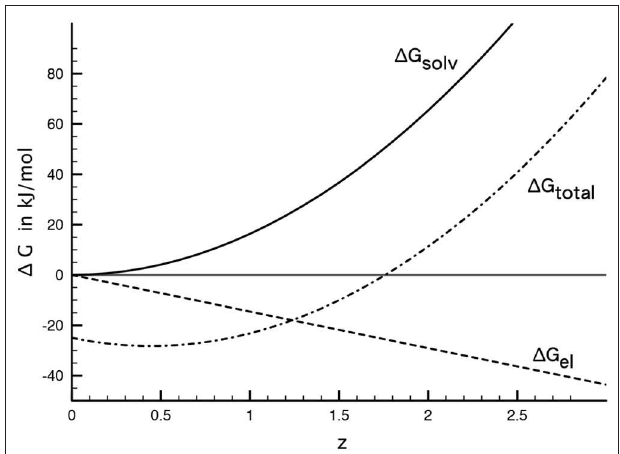
FIGURE 6 | Solvation and electrostatic contribution to total free energy of adsorption in the Stern layer. For parameters see text. The chemical contribution of 1 G chem = − 25 kJ/mol (not shown) is added to the total adsorption free